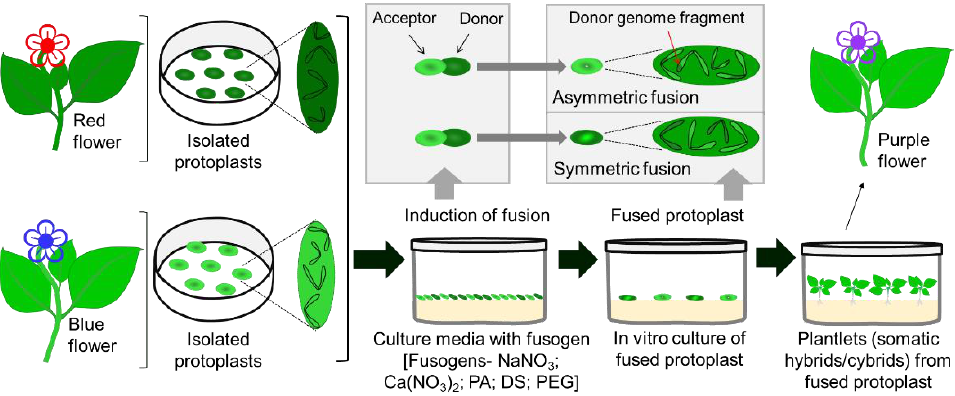
Figure 5. Illustration of somatic hybrid or cybrid development through protoplast fusion. Here, NaNO 3 ; sodium nitrate, Ca(NO 3 ) 2 ; calcium nitrate, PA; polyvinyl alcohol, DS; dextran sulfate, polyethylene glycol (PEG).